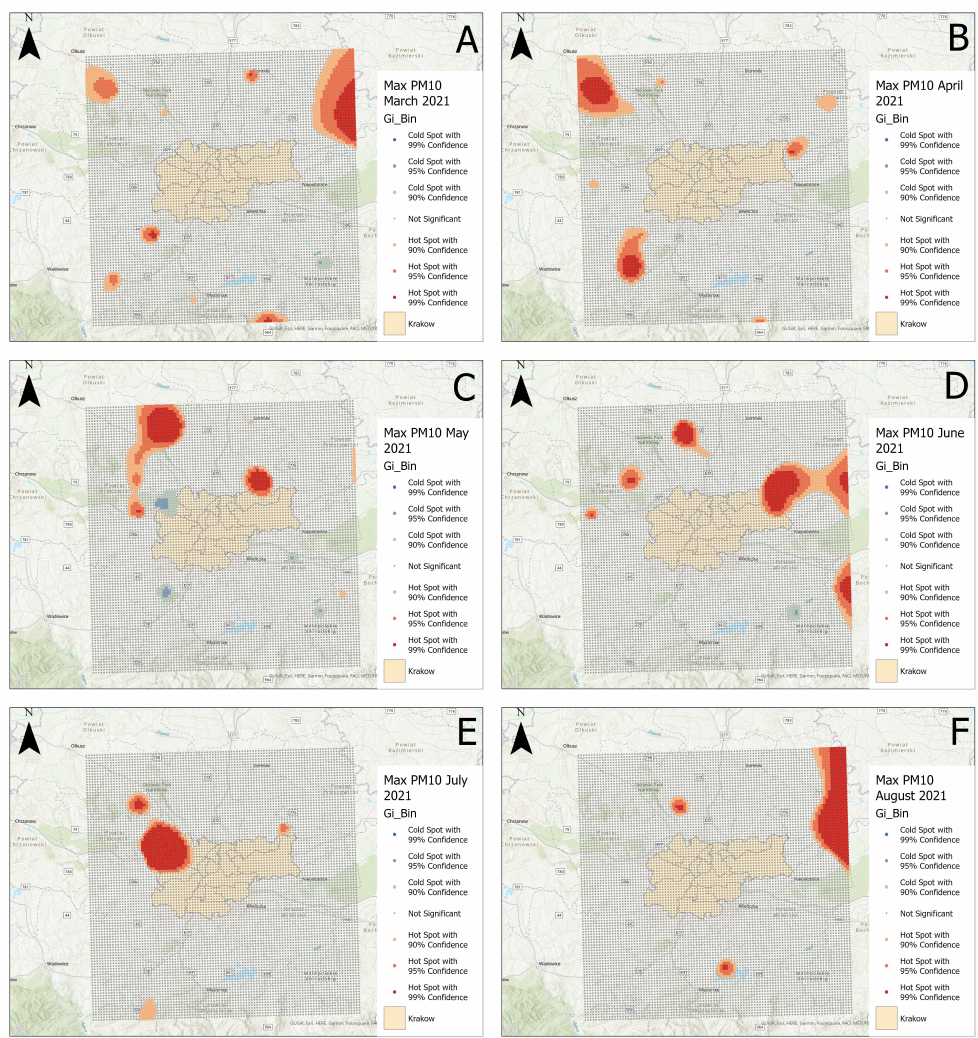
Figure 15. Hot-spots and cold-spots maps for monthly maximum PM10 concentration using Getis- Ord G ∗ . The maps illustrate clustering in March ( A ), April ( B ), May ( C ), June ( D ), July ( E ), and i August 2021 ( F